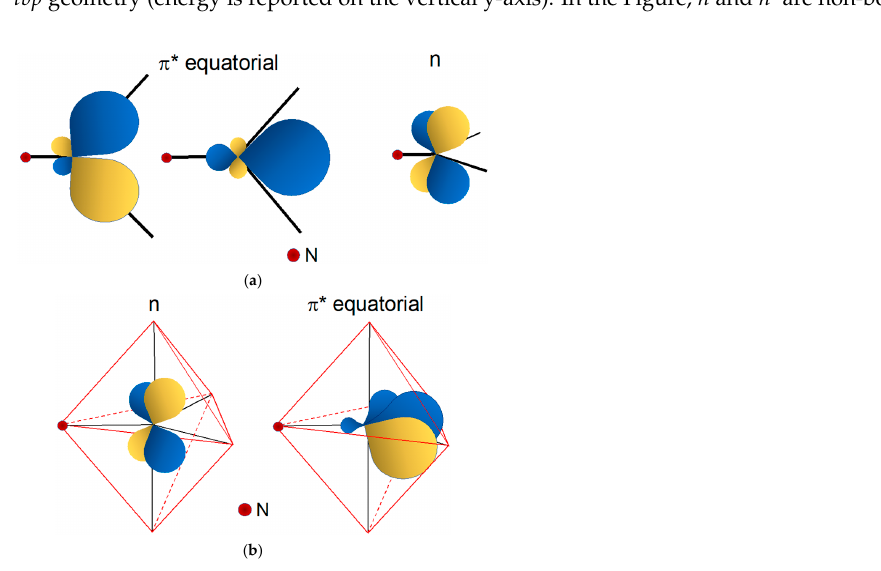
Figure 6. ( a ) Qualitative probability density distribution of the two isoenergetic π * frontier orbitals (FOs) and of the non-bonding n orbital of the Re(N) functional group in a tbp symmetry. ( b ) Arrangement of the three FOs in a trigonal bipyramidal geometry. The two empties π * FOs lie on the trigonal equatorial plane and are separated from the filled n FO positioned on a perpendicular plane.